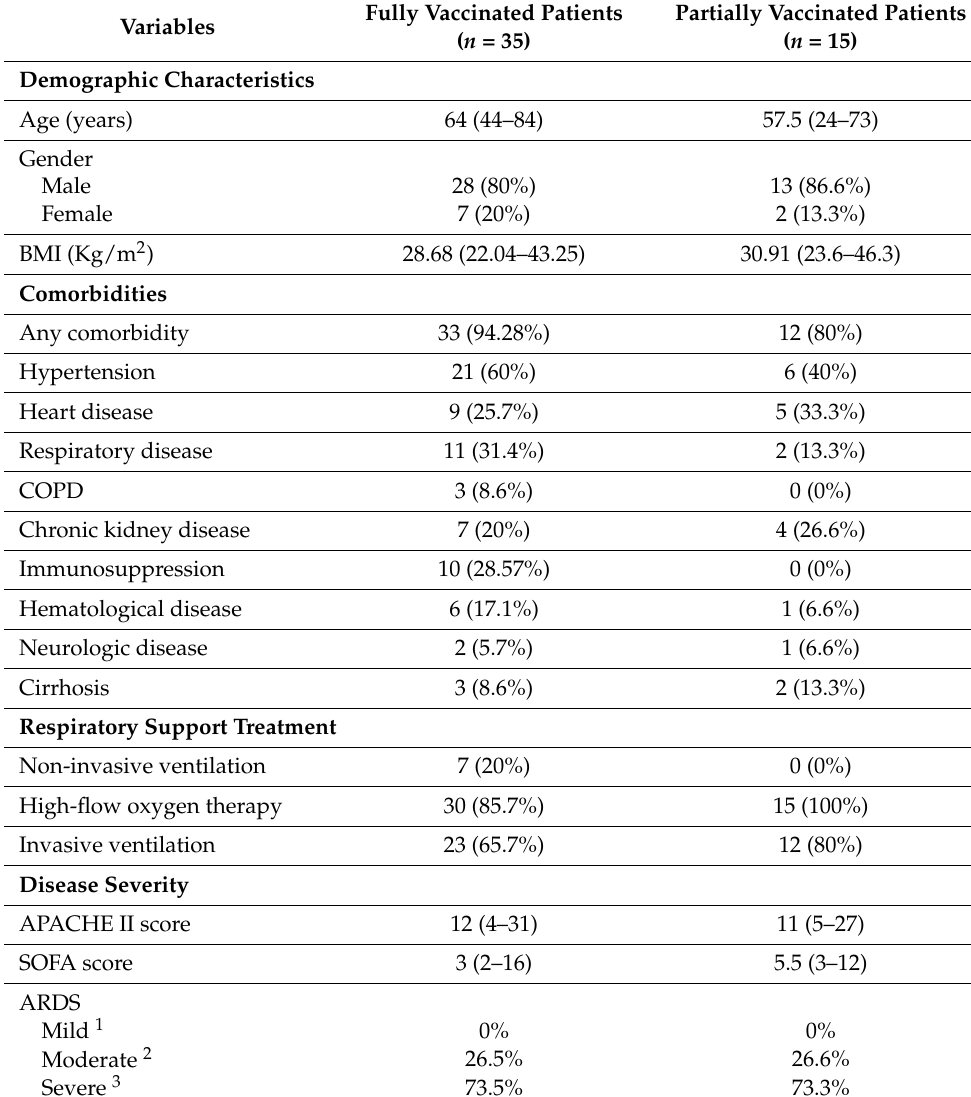
Table 2. Clinical profile of patients according to grade of